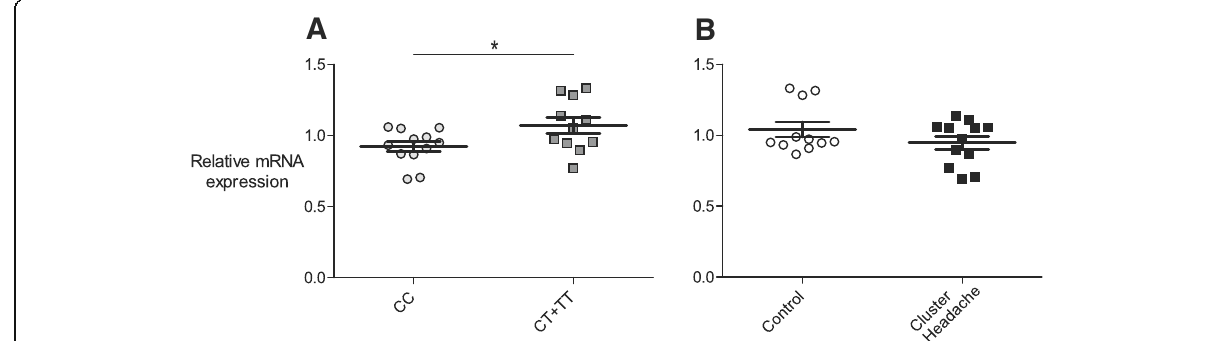
Fig. 1 MTDH mRNA expression is affected by rs1835740. MTDH mRNA expression levels were normalized to the reference gene PDHB and to a reference sample consisting of pooled cDNA from all individuals. Horizontal bars represent group means, SEM in error bars, groups were compared using an unpaired, two-tailed t-test. a ) mRNA levels are compared between individuals with two major alleles (CC) and individuals carrying one or more T alleles (CT+TT) at rs1835740 regardless of headache diagnosis, p =0.0318. b ) mRNA levels were compared between healthy control subjects and individuals with cluster headache, p